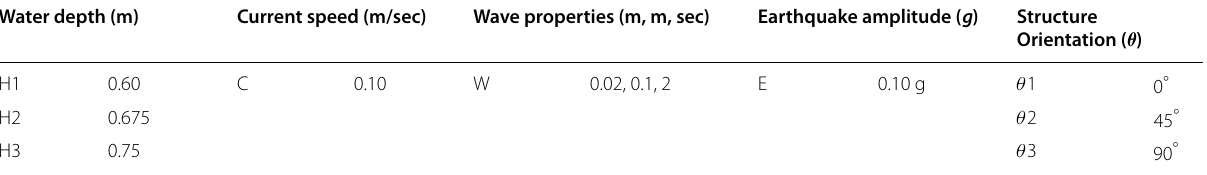
Table 2 Present study’s test